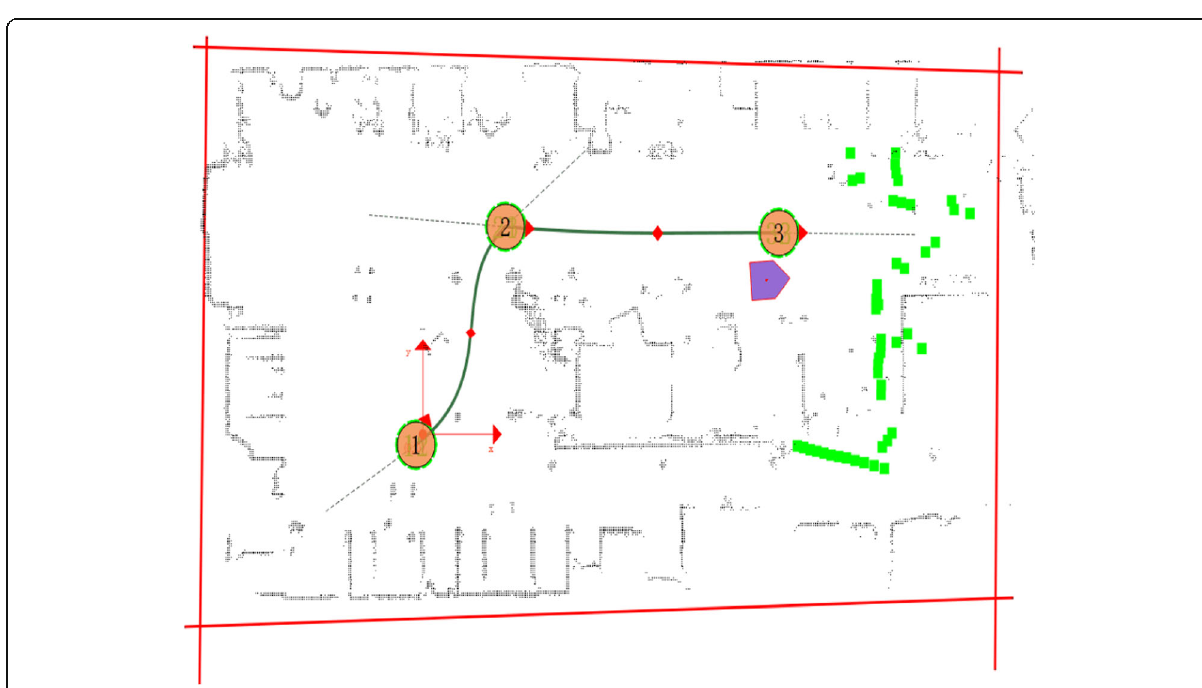
Fig. 5 Robot planning path. The gray part in this figure represents obstacles. The number 1 is the starting point for the robot, and the numbers 2 and 3 are the target points (robot receives the signal sent by the control terminal through the wireless network) of the robot respectively. The curve between the numbers is the actual path of the robot walking, the purple pentagon is the robot, and the green spot is the real-time data scanned by the laser sensor of the